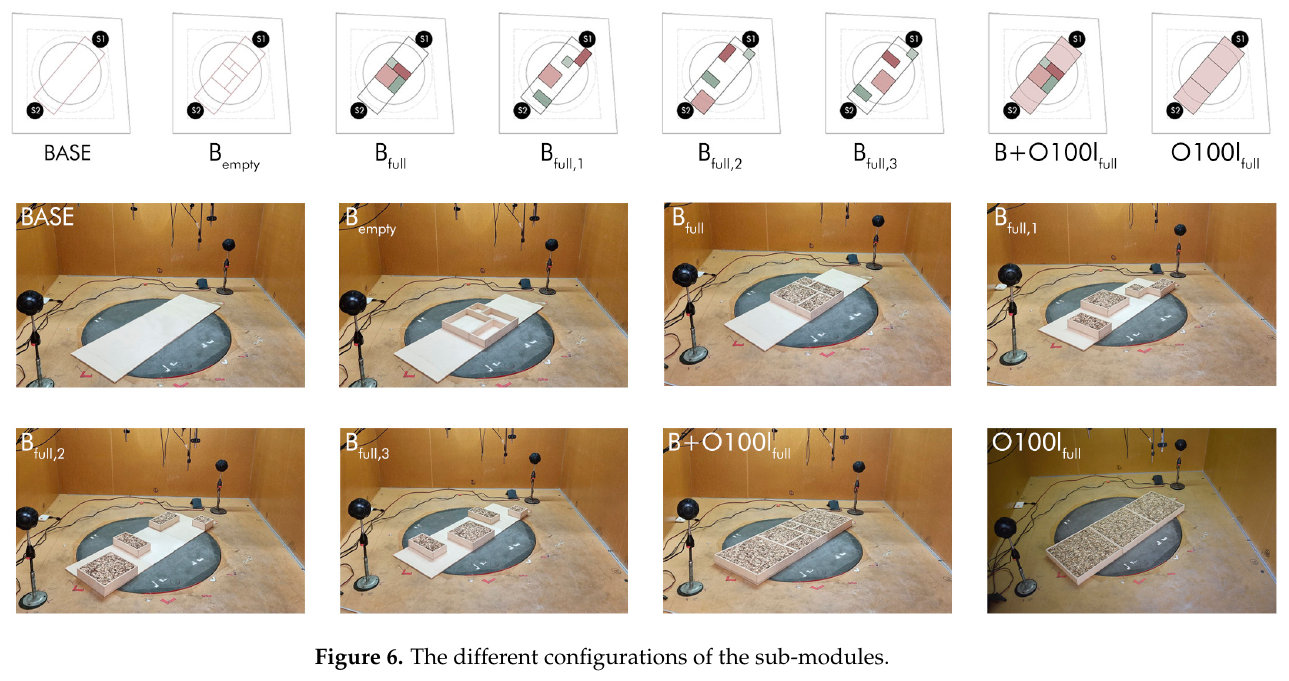
Figure 6. The different configurations of the sub-modules.